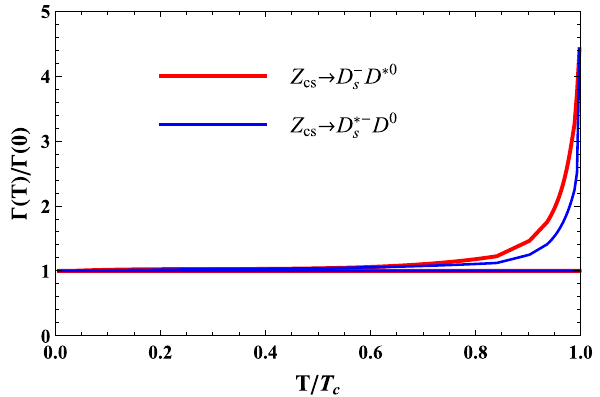
Fig. 4 Variation in the ratio of temperature-dependent decay width of Z cs → D − s D ∗ 0 / D ∗− s D 0 to its value in vacuum according to T / T c for T c = 155